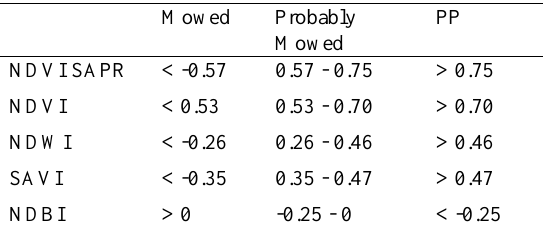
Table 3. Threshold defined according to tables